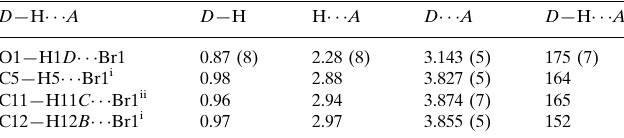
Hydrogen-bond geometry (A˚ , (cid:3)